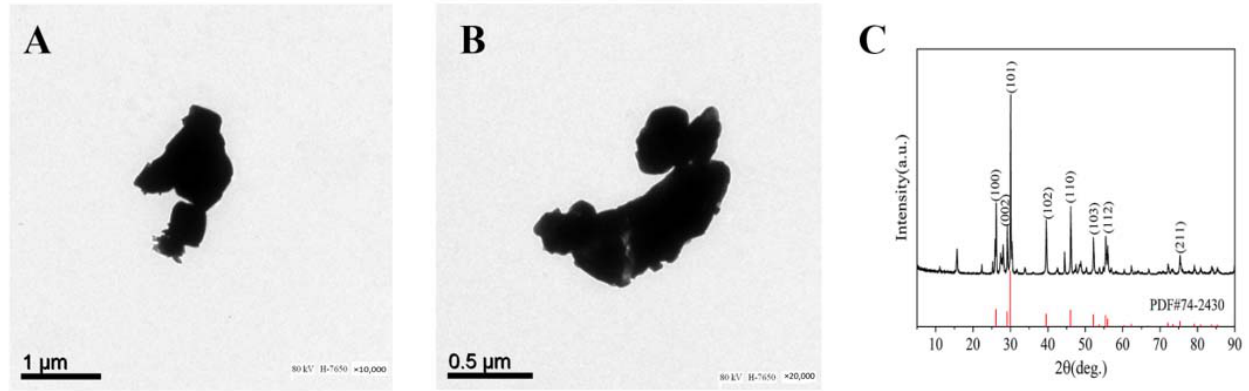
Figure 1. TEM images of La 2 O 3 NPs (( A ) 10,000 × and ( B ) 20,000 × ), and XRD pattern ( C ). The black curve represents the La 2 O 3 NPs sample, and the red curve represents the standard.